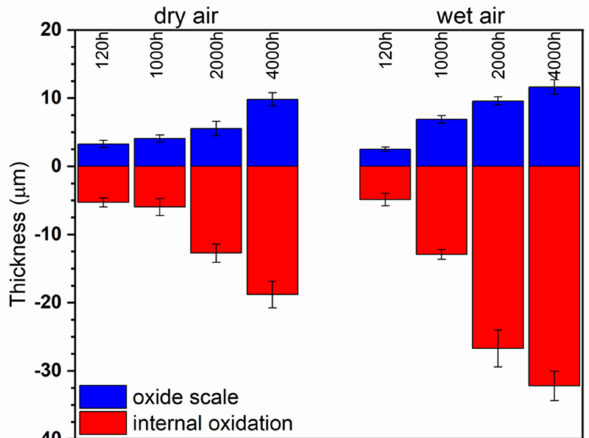
Figure 9. Thickness of the oxide scale and depth of internal oxidation zone formed in the 718Plus superalloy after oxidation at 850 °C for 120, 1000, 2000 and 4000 h in dry air (left) and wet (right) air.